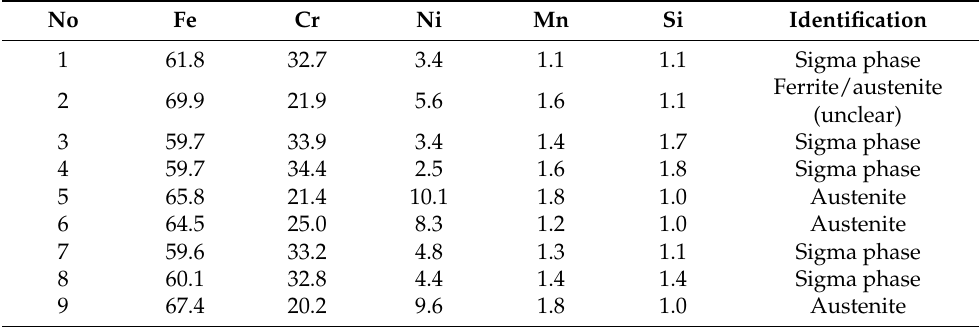
elements in wt. %, and identification of